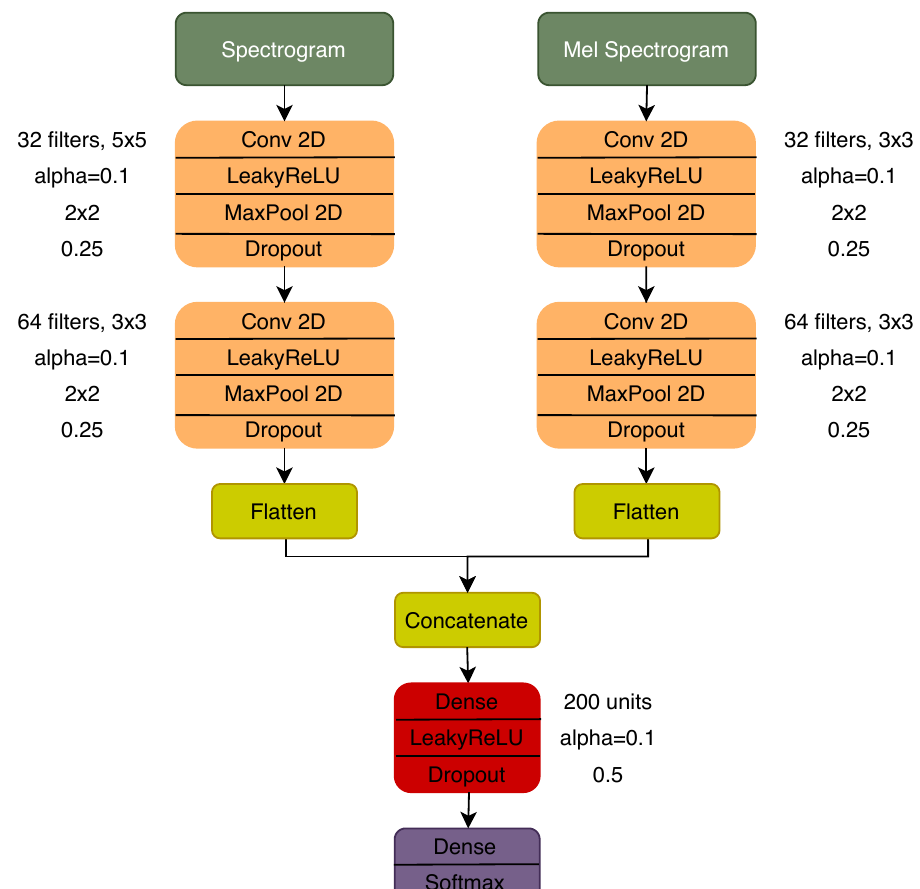
Figure 3. Dual input CNN